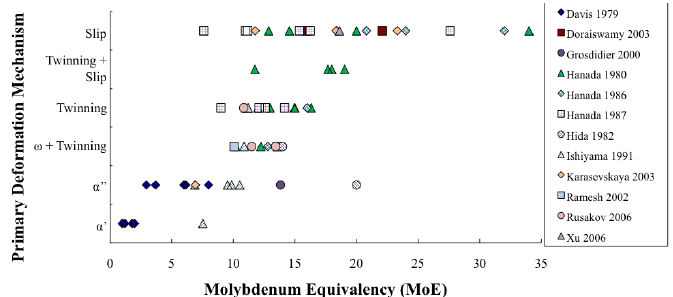
Figure 15. The experimental results that were reported for stress-induced deformation mechanisms as a function of MoE value for a broad range of beta Ti alloy compositions, microstructures, and mechanical property test methods [33]. (Reprinted with permission from JOM, vol. 67, no. 6, R. P. Kolli et al., Phase Stability and Stress-Induced Transformations in Beta Titanium Alloys, 1273–1280,